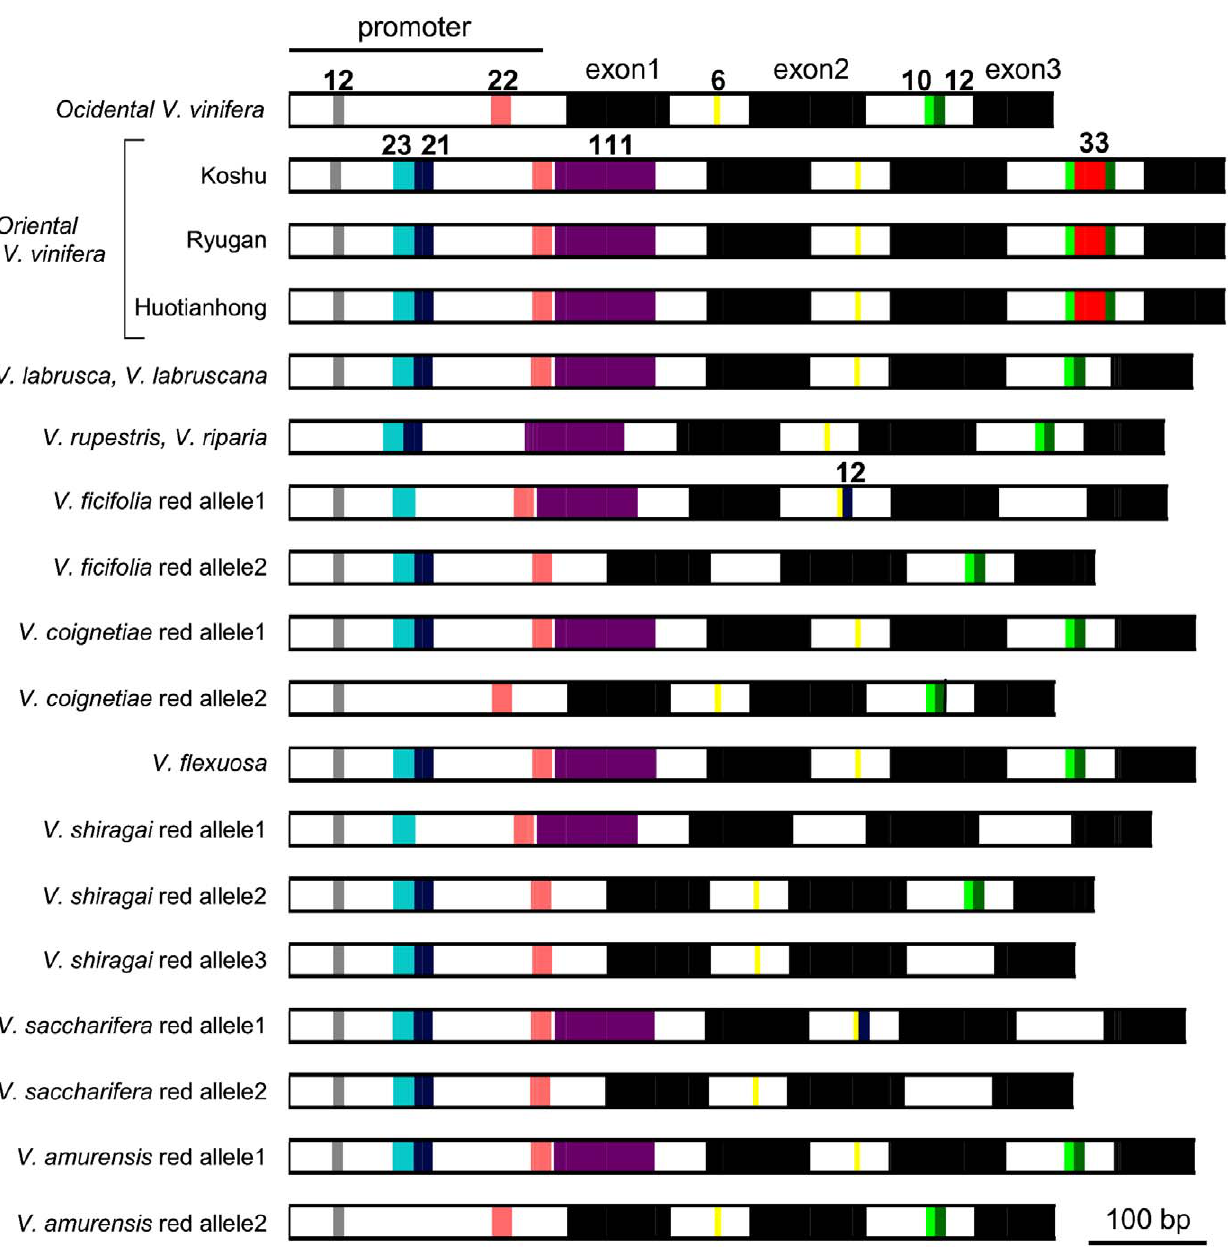
Figure 4. Comparison of MybA1 gene structure in Vitis grapes. Black boxes indicate three exons in the MybA1 gene. Other colored boxes indicate unique gene fragments in each MybA1 gene sequence. The same colored box indicates the same gene fragment. Numbers on the boxes indicate the base pairs in each gene fragment. Single-nucleotide polymorphisms among Vitis species are not shown.